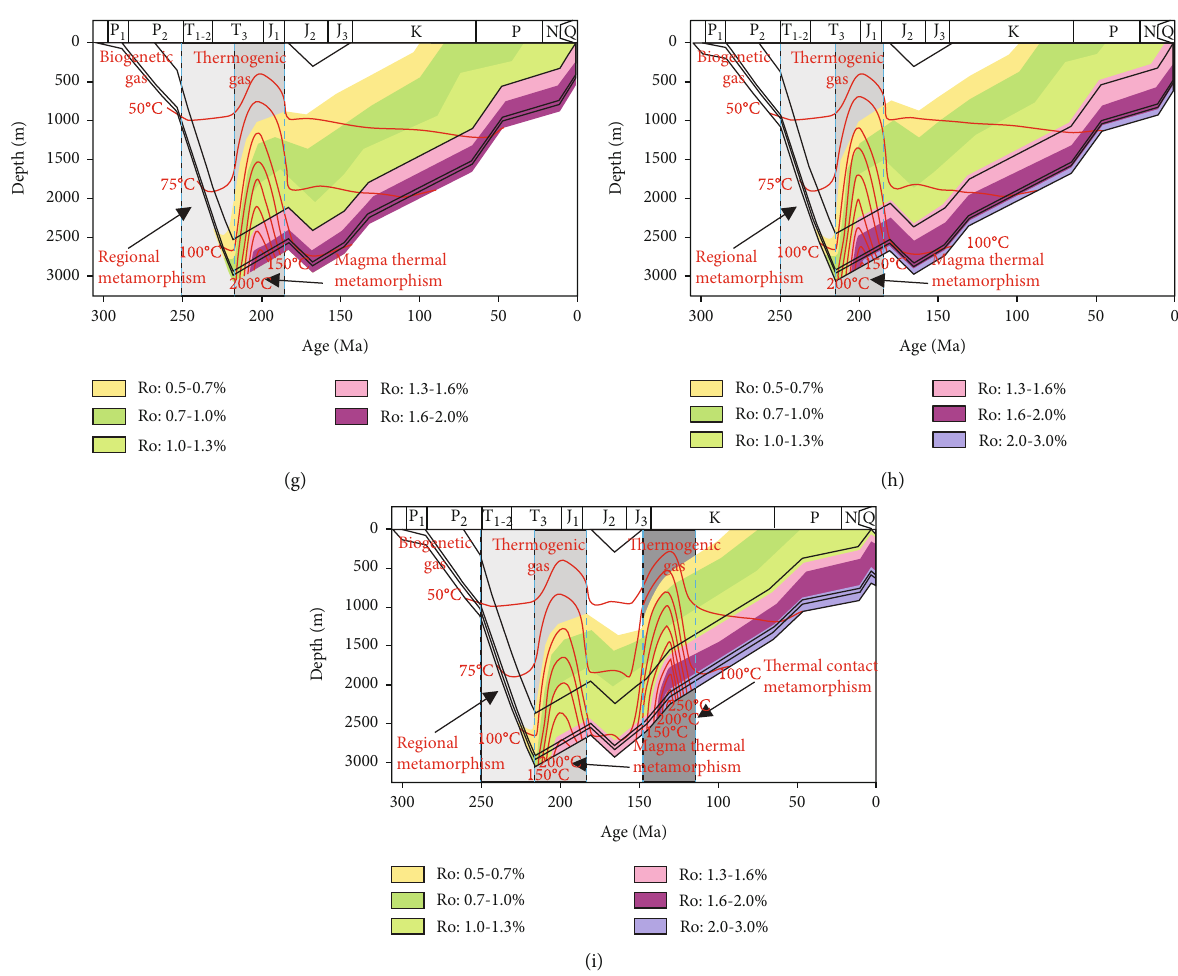
Figure 6: Temperature and maturity history curve for the coal-bearing strata of well XST-170 (a), XSM-055 (b), XST-019 (c), XSD-051 (d), XSD-099 (e), GJ-01 (f), GJ-03 (g), GJ-06 (h), and XSM-169